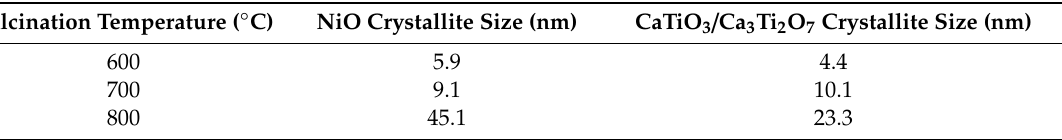
NMC412 catalyst prepared at di ff erent calcination temperatures as obtained from XRD